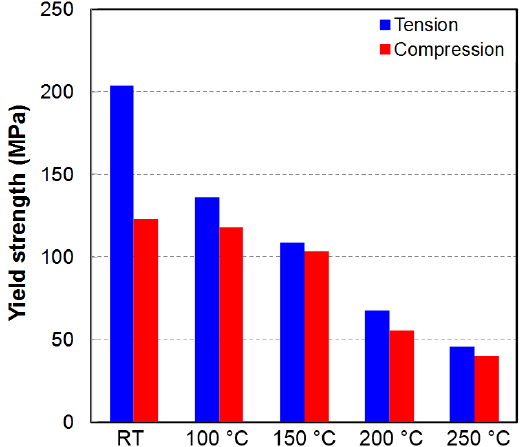
Figure 15. Comparison of yield stress in uniaxial tension and compression tests at different temperatures.